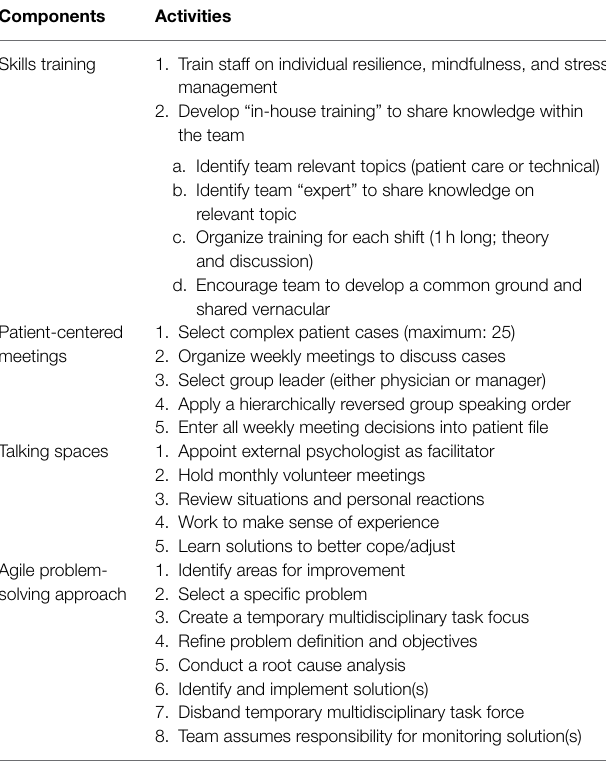
TABLE 1 | Interdependent components of the participatory interventional approach.